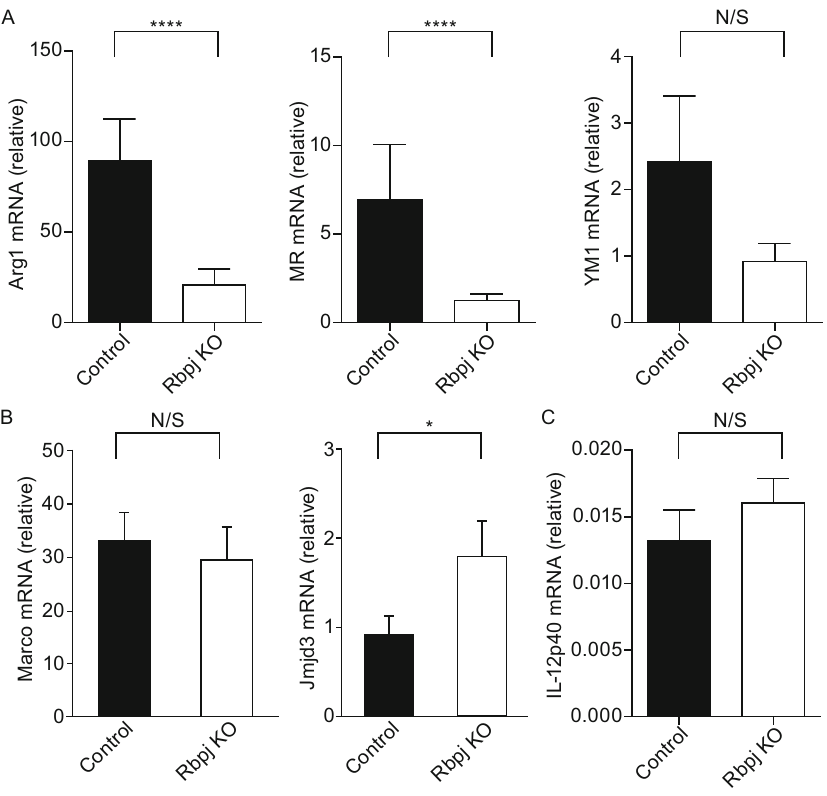
Figure 2. Crucial role for Rbpj in regulating M2 macrophage polarization in response to chitin administration in vivo . Total mRNA was prepared from PECs isolated from WT and Rbpj cKO mice 24 h after administration of chitin, and mRNA expression of Arg1, MR, Ym1, Marco, Jmjd3, and IL-12p40 (relative to GAPDH mRNA) was measured using quantitative real-time PCR. **** P < 0.0001 (two-tailed Student ’ s t -test). * P < 0.05 (two-tailed Student ’ s t -test). Results are representative of four independent experiments, each with two-four pairs of littermate mice (analyzed